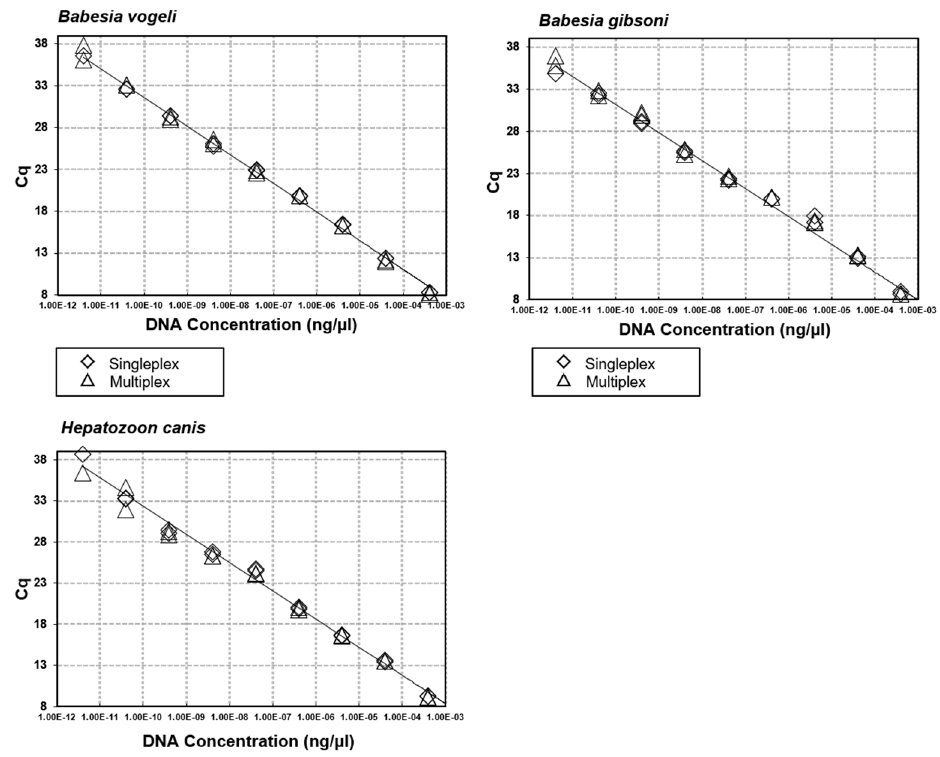
Figure 3. Singleplex and multiplex qPCR efficiencies. Optimisation and comparison of the sensitivity and efficiency of each singleplex and multiplex qPCR using gBlock Gene Fragment controls for B. vogeli , B. gibsoni and H. canis .